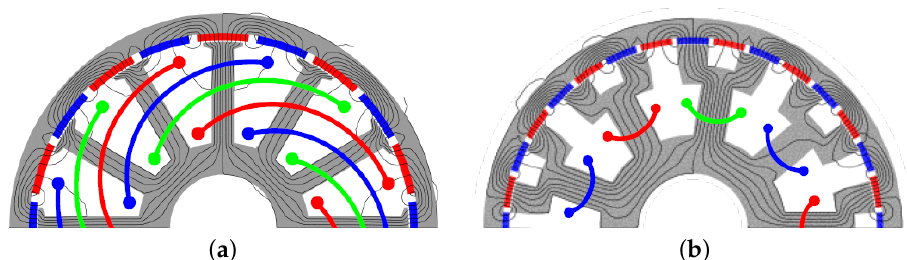
Figure 4. Typical structures of Type-A PMVMs with ( a ) conventional overlap-winding, ( b ) tooth concentrated, split tooth (©[2020] IEEE. Reprinted, with permission from [20]).